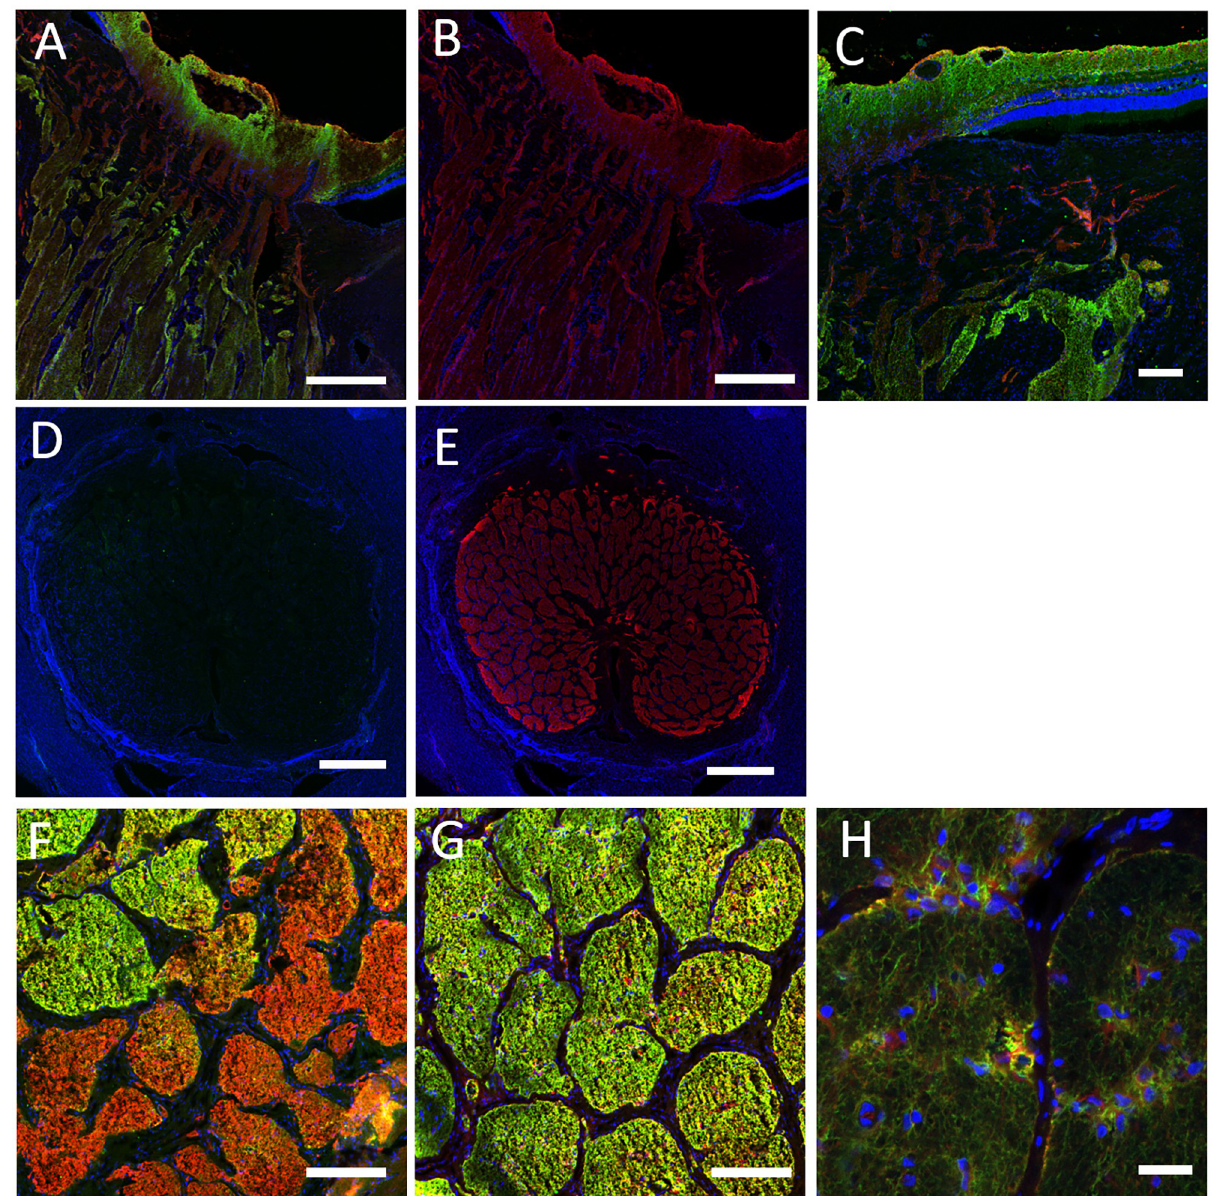
Fig 4. Longitudinal (A, B) and cross-sections (C-F) of porcine tissue labeled for aquaporin 4 (AQP4, green), glial fibrillary acidic protein (GFAP, red) and DAPI (blue). Labeling for GFAP is visible throughout (A-C), in retina through the lamina and into the myelinated nerve, while AQP4 is only visible in the retina and myelinated nerve. Cross-sections of the lamina region (D, E) show label for GFAP but not for AQP4. Higher power cross- section of the transition zone from lamina to myelin shows co-incident labeling for GFAP and AQP4 in central lamina (F). In myelinated nerve, both labels are present, but are somewhat more distinct in position from each other (G). High power image (40x) shows the GFAP and AQP4 co-localization (yellow/orange) in astrocytic cells within and along the periphery of nerve bundles. Scale Bar: 150 μ m (A, B), 50 μ m (C, D, E), 25 μ m (F, G) 10 μ m